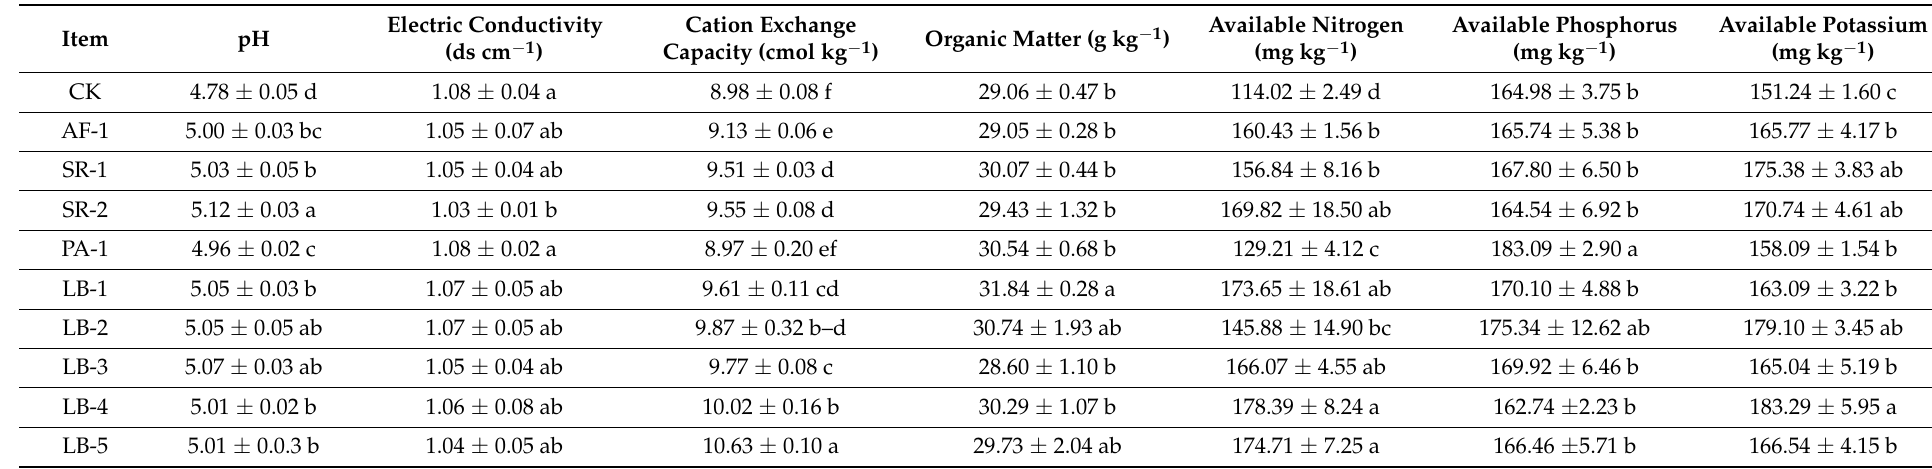
Table 2. The influence of different treatments on soil pH, EC, CEC, OM, AN, AP and